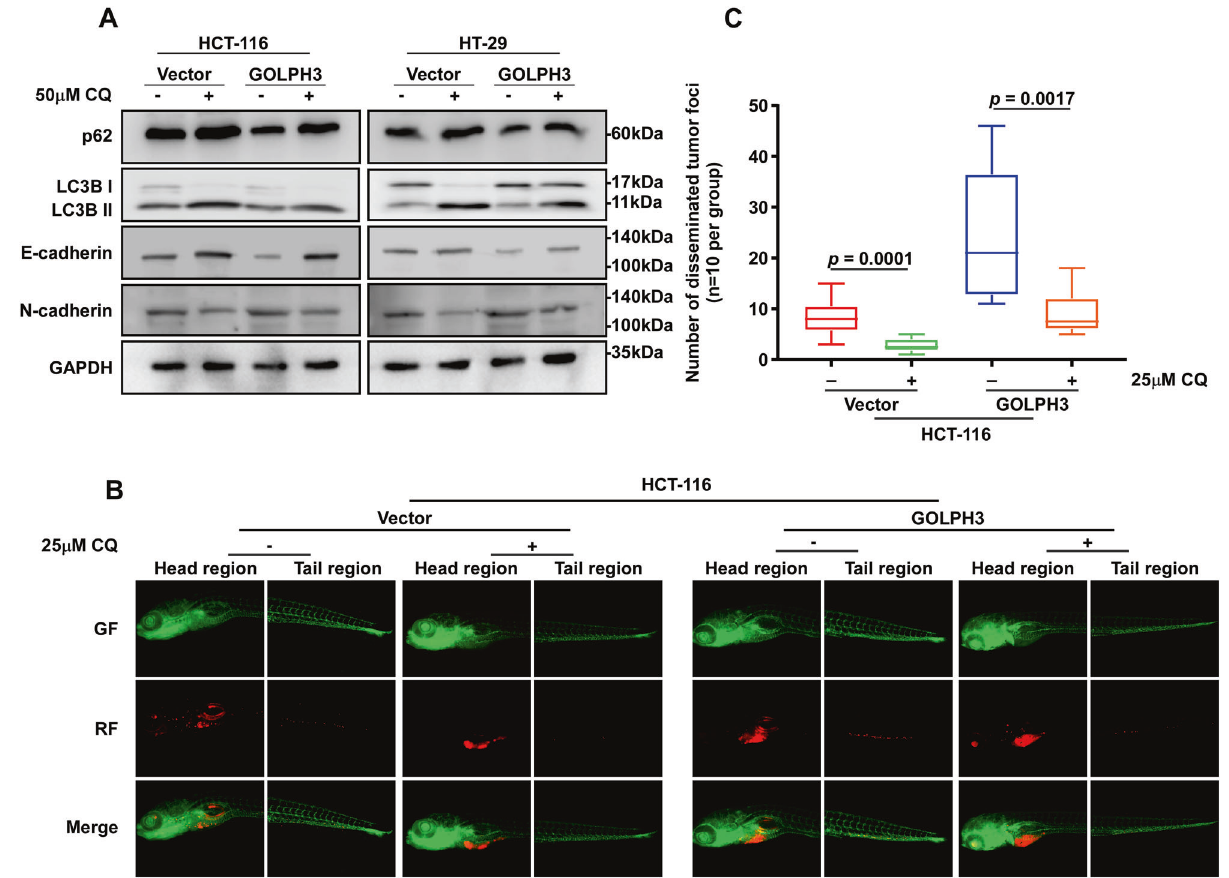
analysis of autophagy inhibition markers (p62 and LC3 II), epithelial markers (E-cadherin), and mesenchymal markers (N-cadherin) was performed. The overexpression of GOLPH3 induced downregulation of p62, LC3 II, and E-cadherin, while it induced upregulation